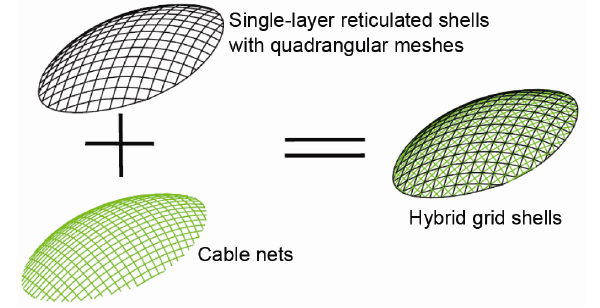
Fig. 1. The hybrid grid shell